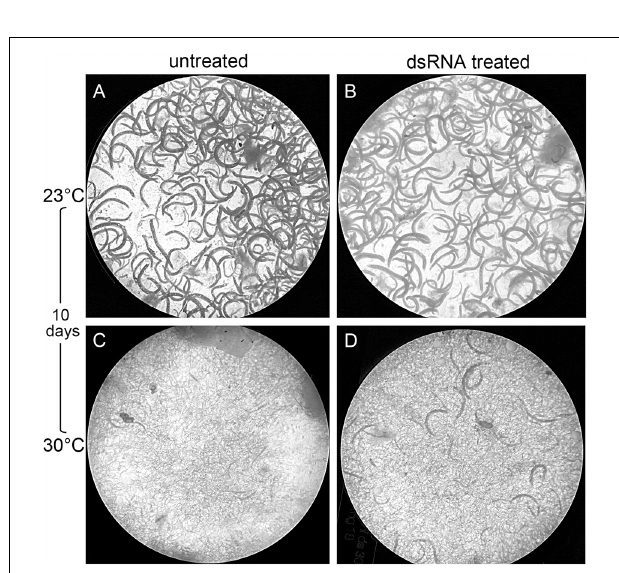
FIGURE 11 | Effects of temperatures on the reproductive potential of treated and untreated Heterorhabditis bacteriophora inside Galleria mellonella larvae after 10 days infection. (A) untreated nematodes at 23 ◦ C; (B) dsRNA treated nematodes at 23 ◦ C; (C) untreated nematodes at 30 ◦ C; (D) dsRNA treated nematodes at 30 ◦